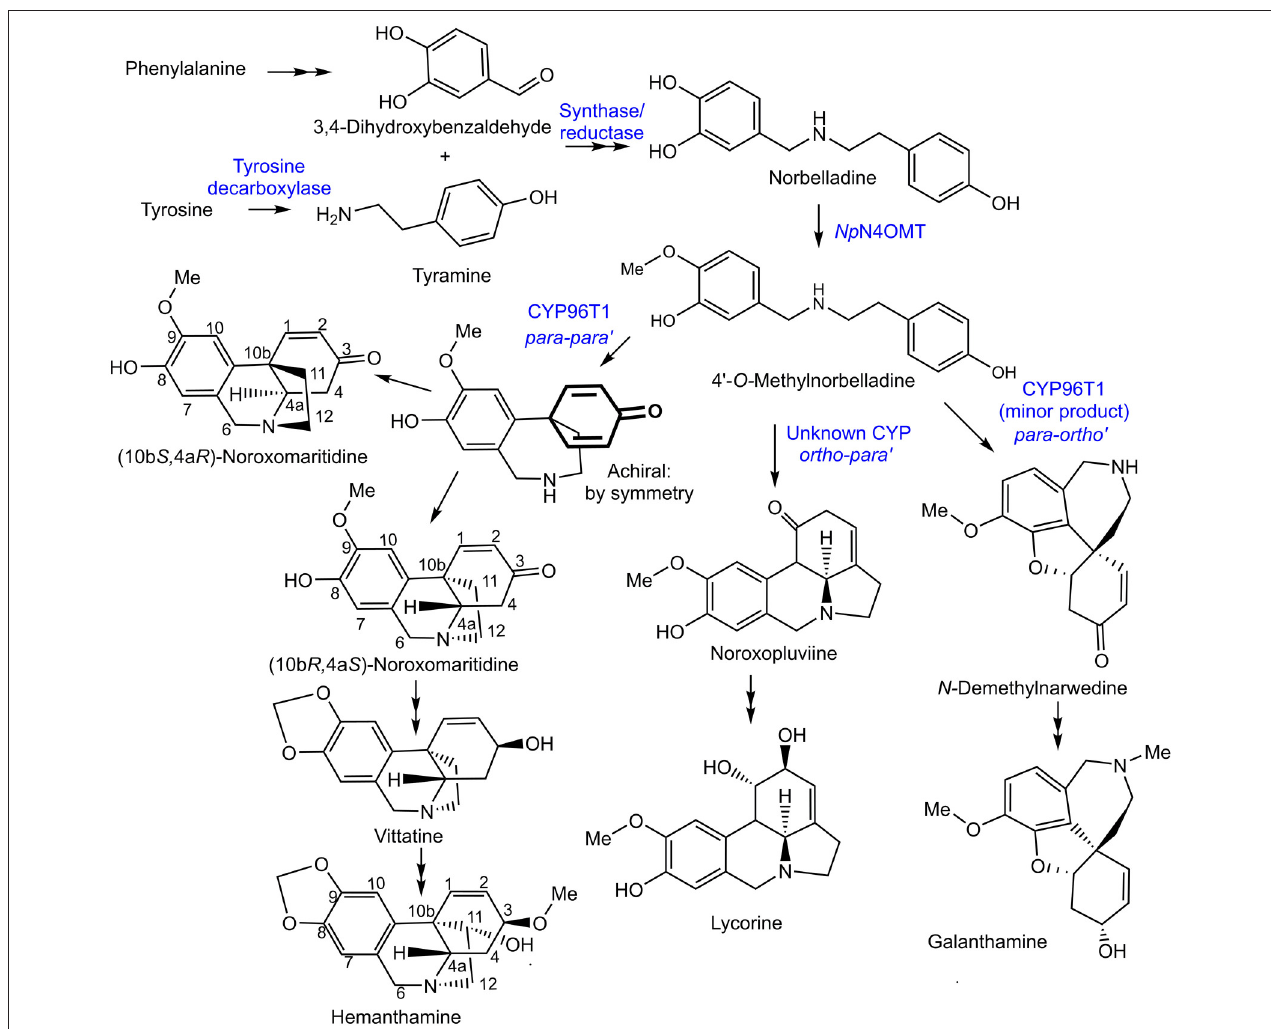
FIGURE 1 | Proposed biosynthetic pathways for representative Amaryllidaceae alkaloids directly derived from C-C phenol coupling. The previously discovered Np N4OMT, the CYP96T1 discovered in this study, and potential enzyme classes involved in each step of the pathways are in